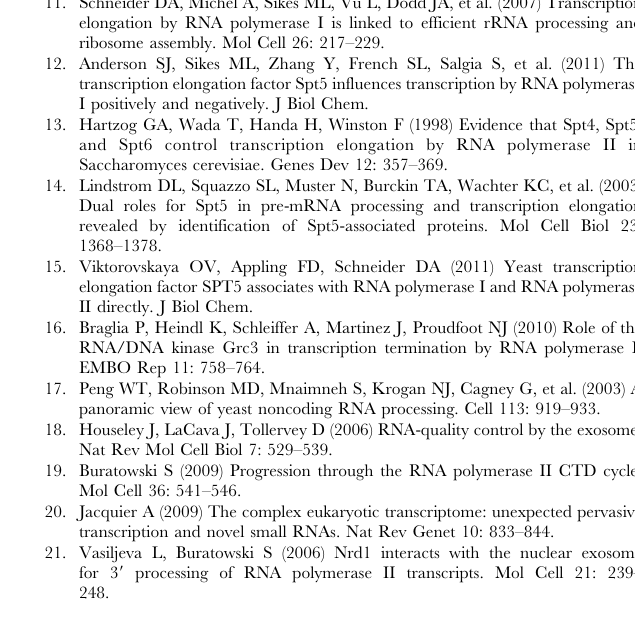
Figure S3 Yeast pre-rRNA processing pathway. A, rDNA unit and probes used in this work. A single large RNA Pol I transcript (35S) encodes three out of the four ribosomal RNAs. The coding sequences for the 18S, 5.8S and 25S rRNAs are flanked by the 5 9 - and 3 9 -external (5 9 - and 3 9 -ETS) and internal transcribed spacers 1 and 2 (ITS1 and ITS2). Cleavage sites (A 0 to E) and the oligonucleotides, used in the Northern-blot hybridiza- tions are indicated. The fourth rRNA (5S) is synthesized independently by RNA Pol III (not represented). B, Pre-rRNA processing pathway. The 35S RNA is initially cleaved at sites A 0 – A 2 by the SSU-processome. The resulting 20S and 27SA 2 pre- rRNAs are destined to the small and large subunit, respectively. The 20S pre-rRNA is exported to the cytoplasm where it is converted into 18S rRNA, following 3 9 -end endonucleolytic cleavage at site D by Nob1. The 27SA 2 pre-rRNA is matured following two alternatives pathways resulting in the production of two forms (short and long) of 5.8S rRNA that differ in size by about 7 nucleotides at their 5 9 -ends. In the major pathway (representing < 80% of molecules), 27SA 2 is endonucleolytically cleaved at site A 3 by RNase MRP, and digested to site B 1S by the exoRNases Rat1-Rai1 and Rrp17. In the minor pathway ( < 20%), the 27SA 2 is cleaved endonucleolytically at site B 1L by an unknown activity. Both forms of 27SB pre-rRNAs are cleaved at site C 2 within ITS2, generating the 7S pre-rRNAs, precursors to the 5.8S, and the 26S pre-rRNA, precursor to the 25S rRNA. The 7S pre-rRNA is digested to site E, corresponding to the 3 9 -end of